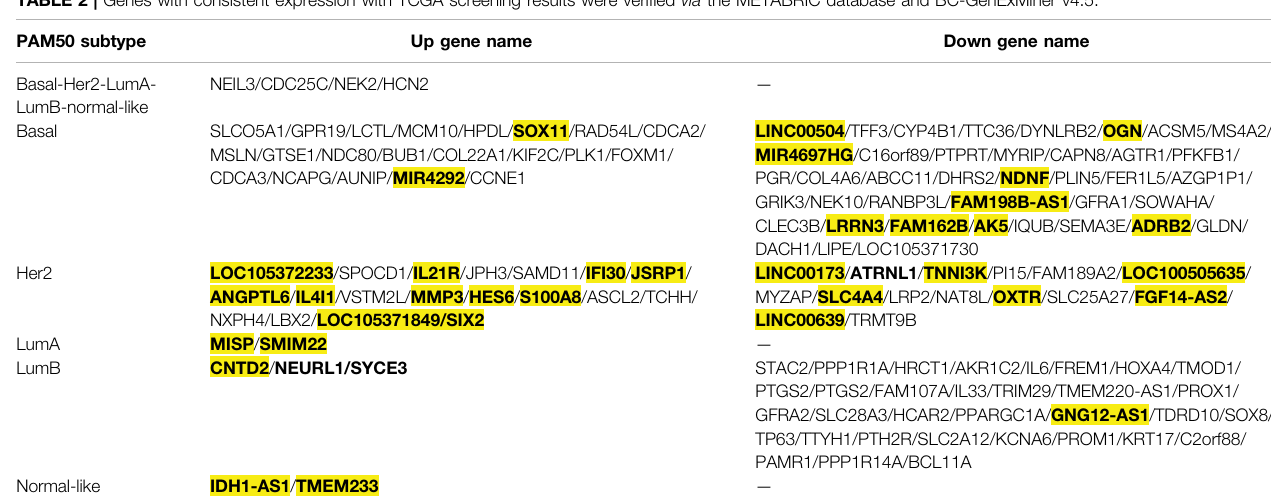
TABLE 2 | Genes with consistent expression with TCGA screening results were veri fi ed via the METABRIC database and BC-GenExMiner